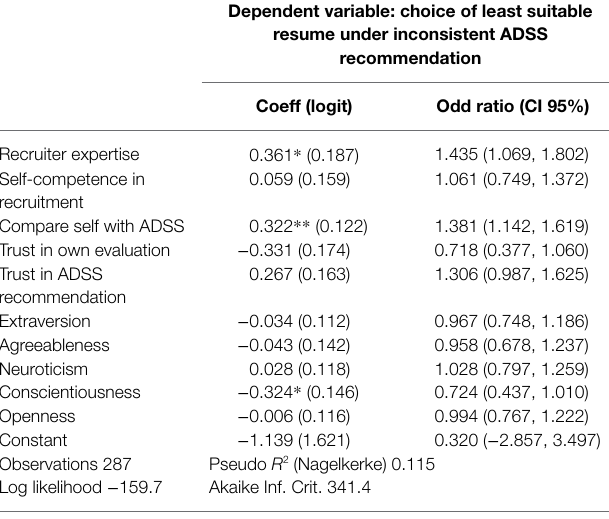
TABLE 6 | Predictors of inconsistent ADSS’ recommendation influence (logistic